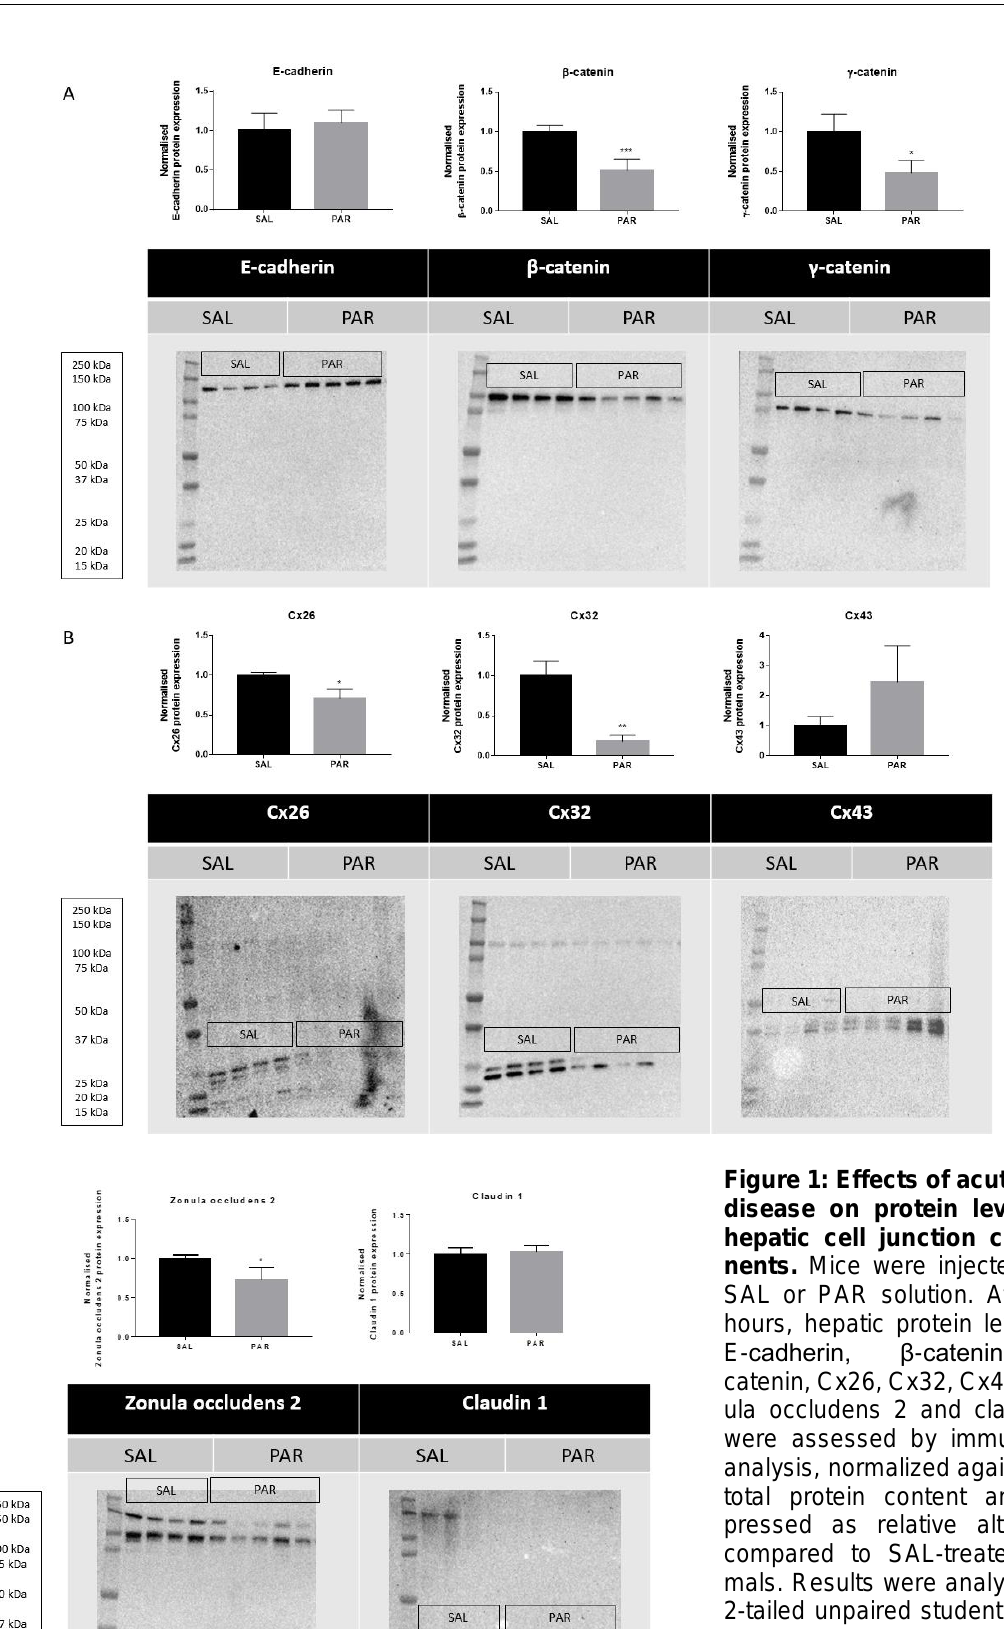
Figure 1: Effects of acute liver disease on protein levels of hepatic cell junction compo- nents. Mice were injected